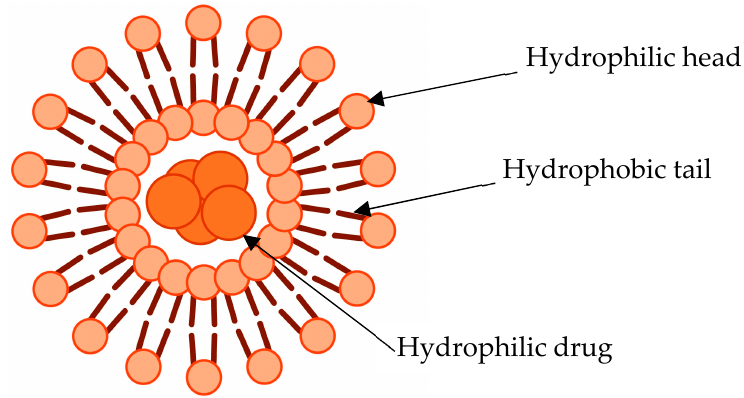
Figure 4. Schematic representation of a basic unilamellar liposome.